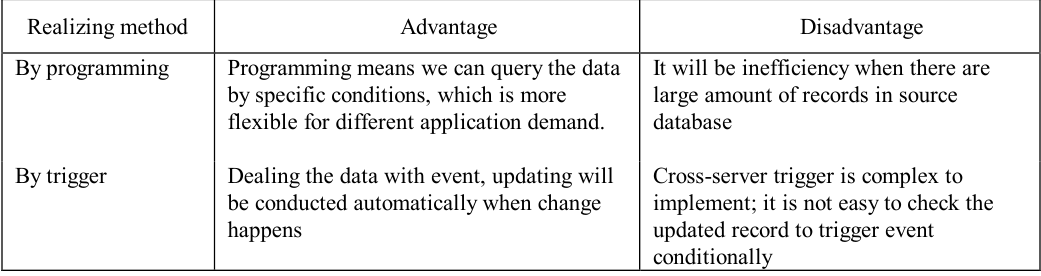
Table 4. Comparison between programming and